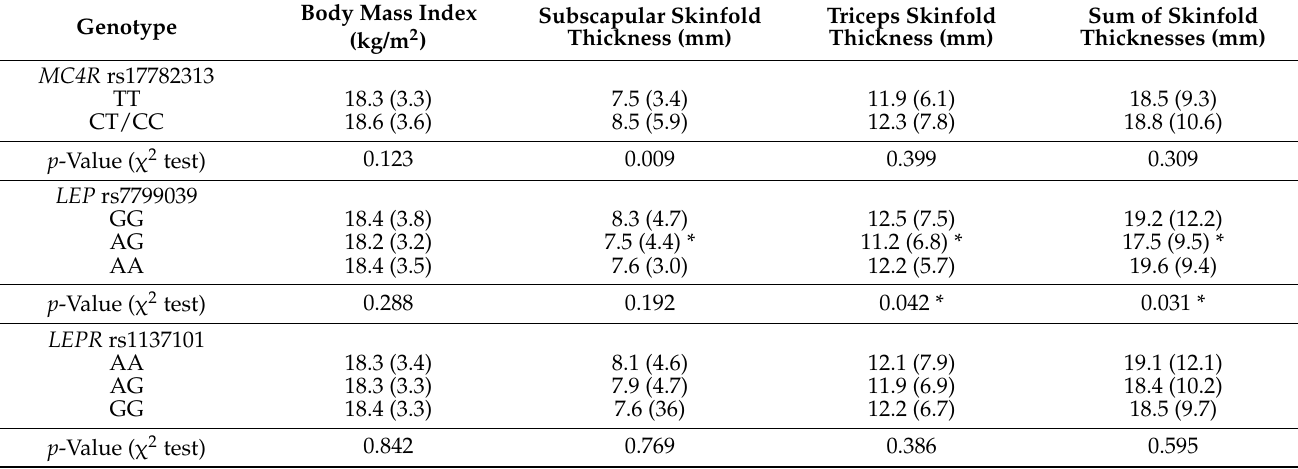
Table 3. Median (IQR) of anthropometric measurements by MC4R , LEP, and LEPR genotypes in childhood. Genotype